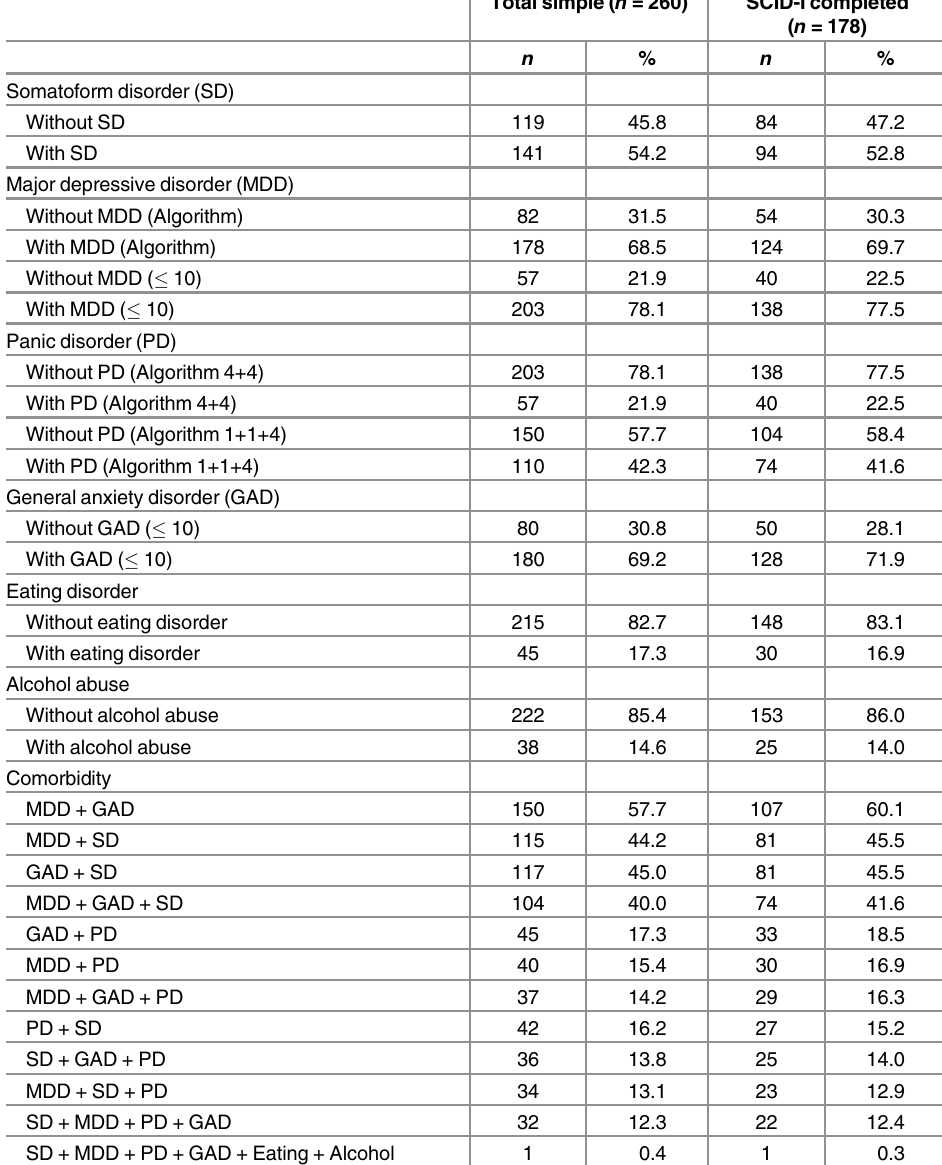
Table 2. PHQ diagnoses and comorbidity of total and SCID-I completed